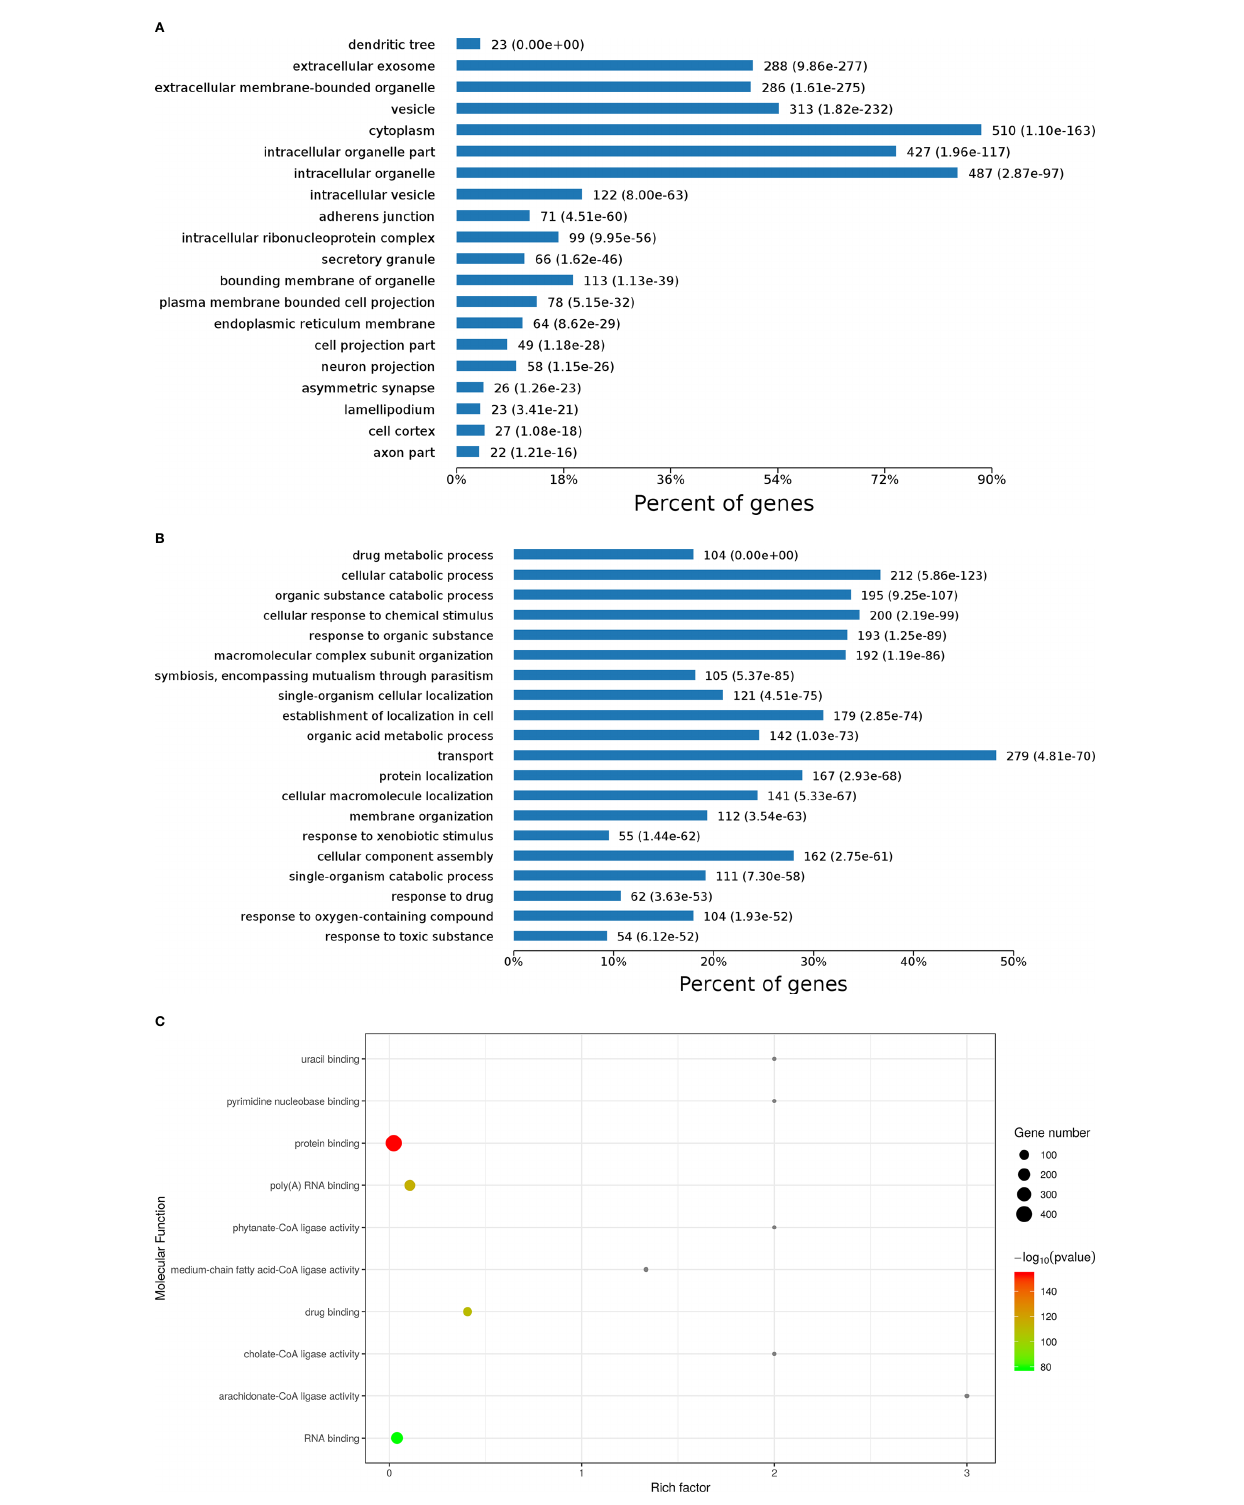
FIGURE 2 | Gene ontology (GO) analysis results of differentially expressed proteins (DEPs) including cellular component (A) , biological process (B) , and molecular function (C) analysis and